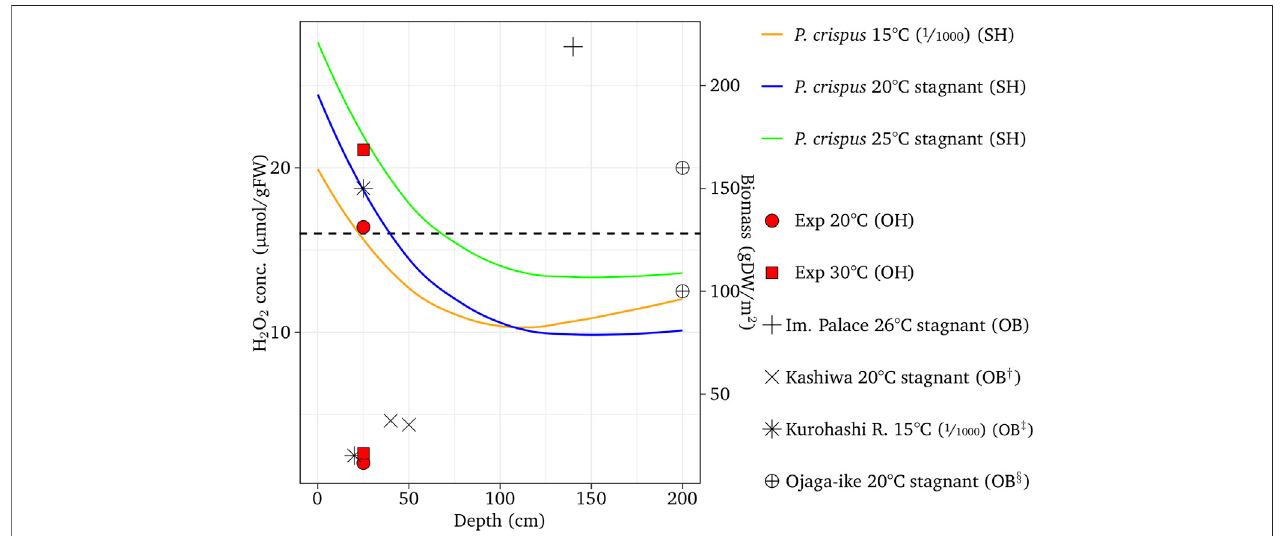
FIGURE 8 | Simulated H 2 O 2 concentrations with different temperatures compared with the observed results for P. crispus compared with observed data. ‘ OH ’ , ‘ SH ’ and ‘ OB ’ designate observed H † , ‡ and § designate Shinohara et al. (2014), Takahashi and Asaeda 2 O 2 , simulated H 2 O 2 , and observed biomass, respectively. (2014), and Kunii (1984), respectively. The fractions in the parentheses are channel slopes.